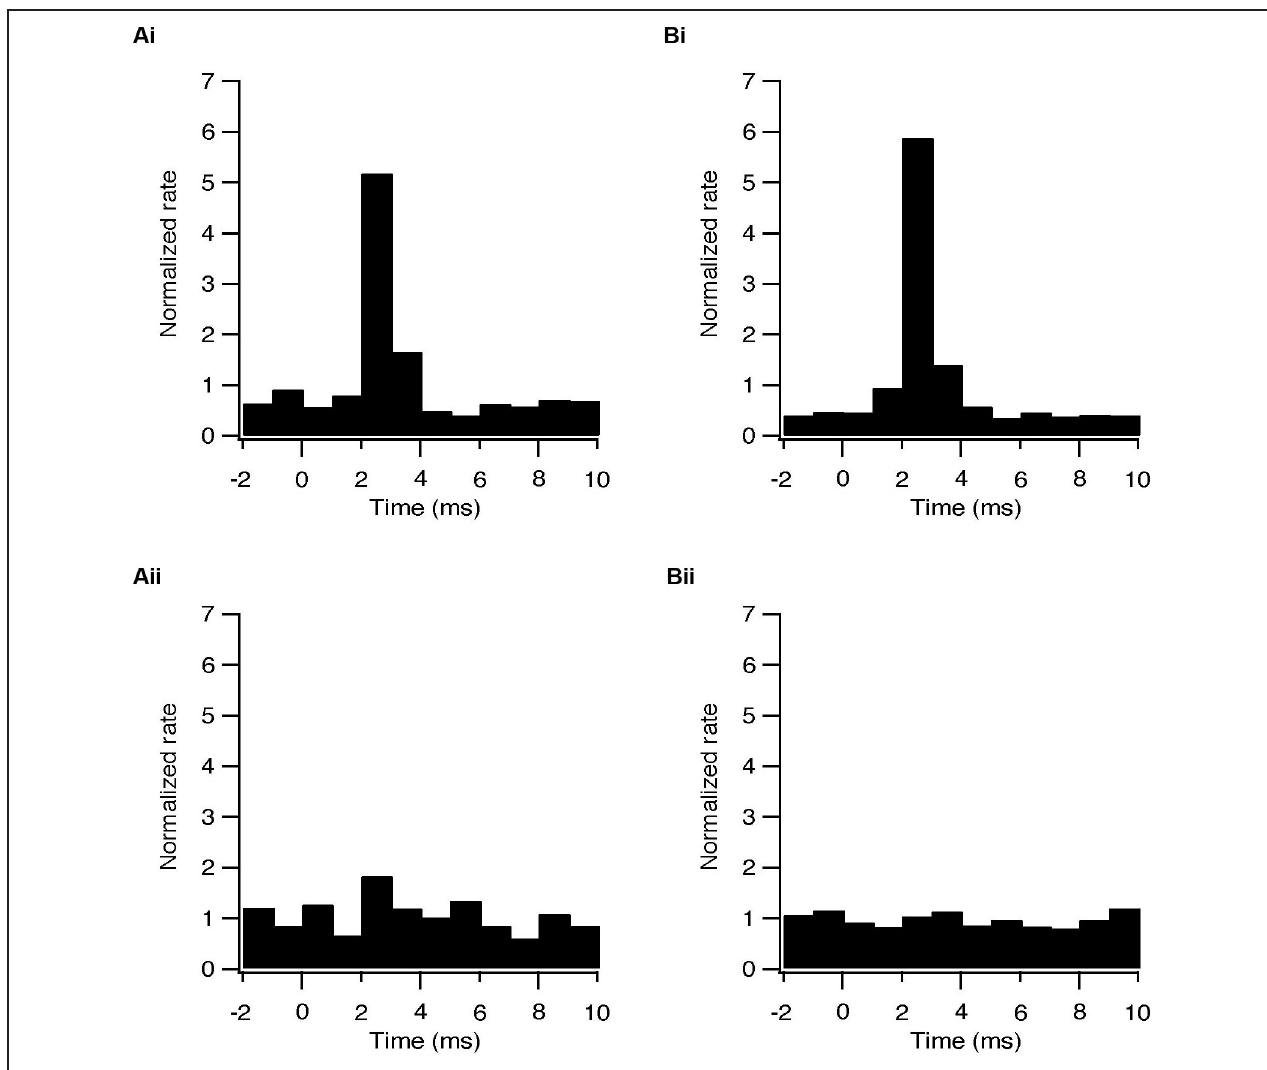
FIGURE 4 | Changes in firing pattern are of synaptic origin. (A) Population PSTH of the response to each pulse of subthalamic (i, n = 6) and pallidal (ii, n = 6) neurons under control conditions. (B) Population PSTH of the same neurons following bath application